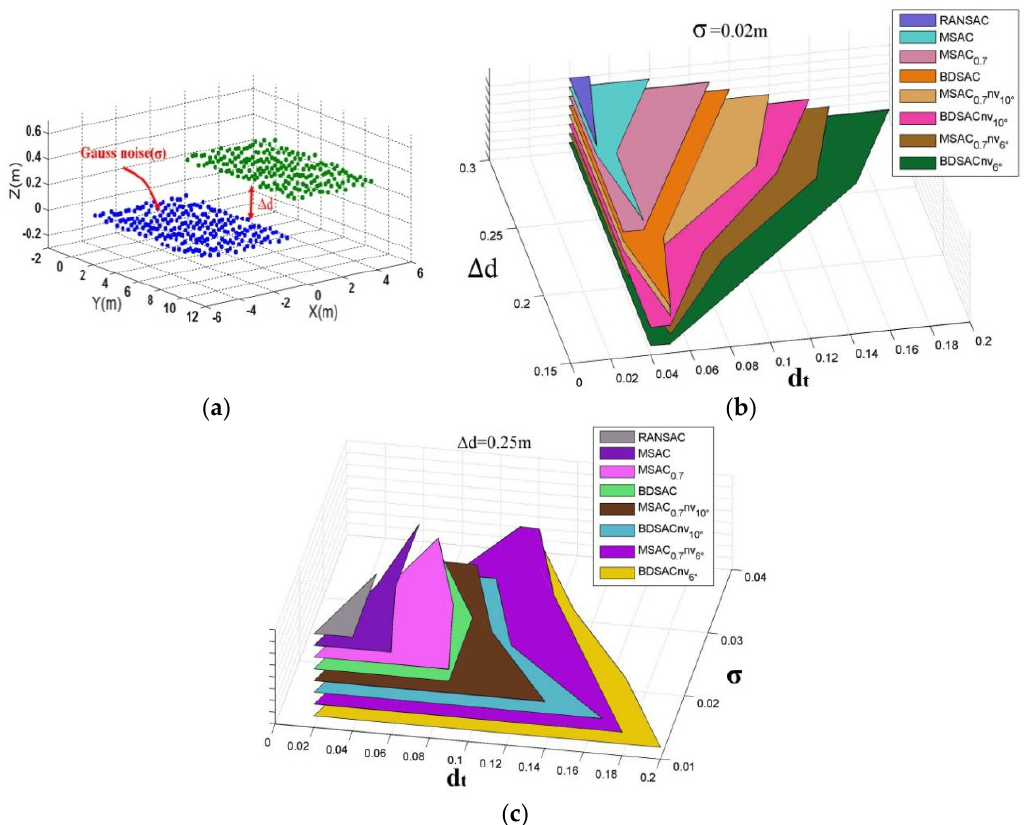
Figure 6. Data sensitivity test. ( a ) Simulated data, with changeable ∆ d and σ ; ( b ) Segmentation results under different ∆ d; ( c ) Segmentation results under different σ . The colored regions depict the range of d t that can produce a correct segmentation.